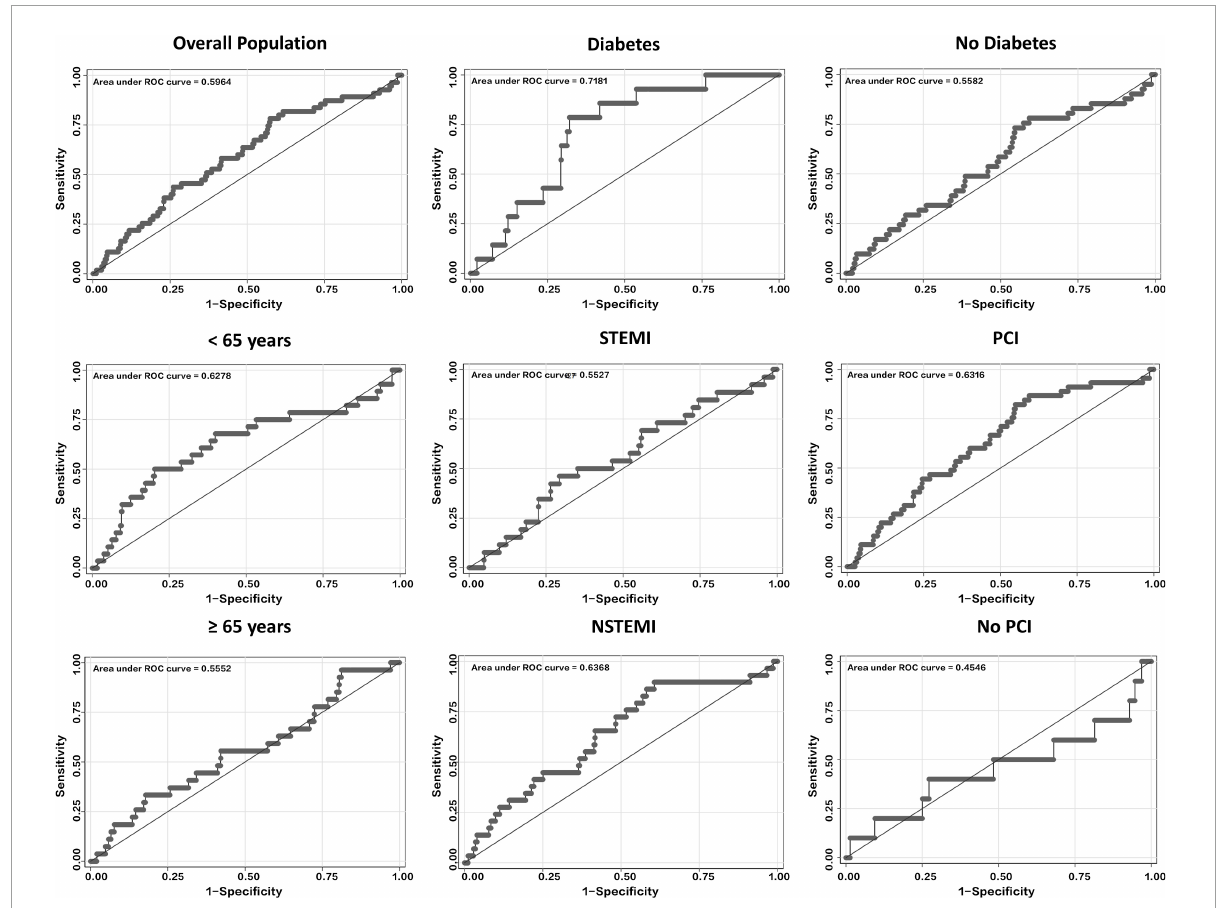
FIGURE1 ROCs curves of SS for predicting in-hospital major bleeding in the overall population and several subgroups, including those of age, diabetes, MI type, and PCI. NSTEMI, non-ST-segment elevation myocardial infarction; PCI, percutaneous coronary intervention; ROC, receiver operating characteristics; SS, SWEDEHEART score; STEMI, ST-segment elevation myocardial